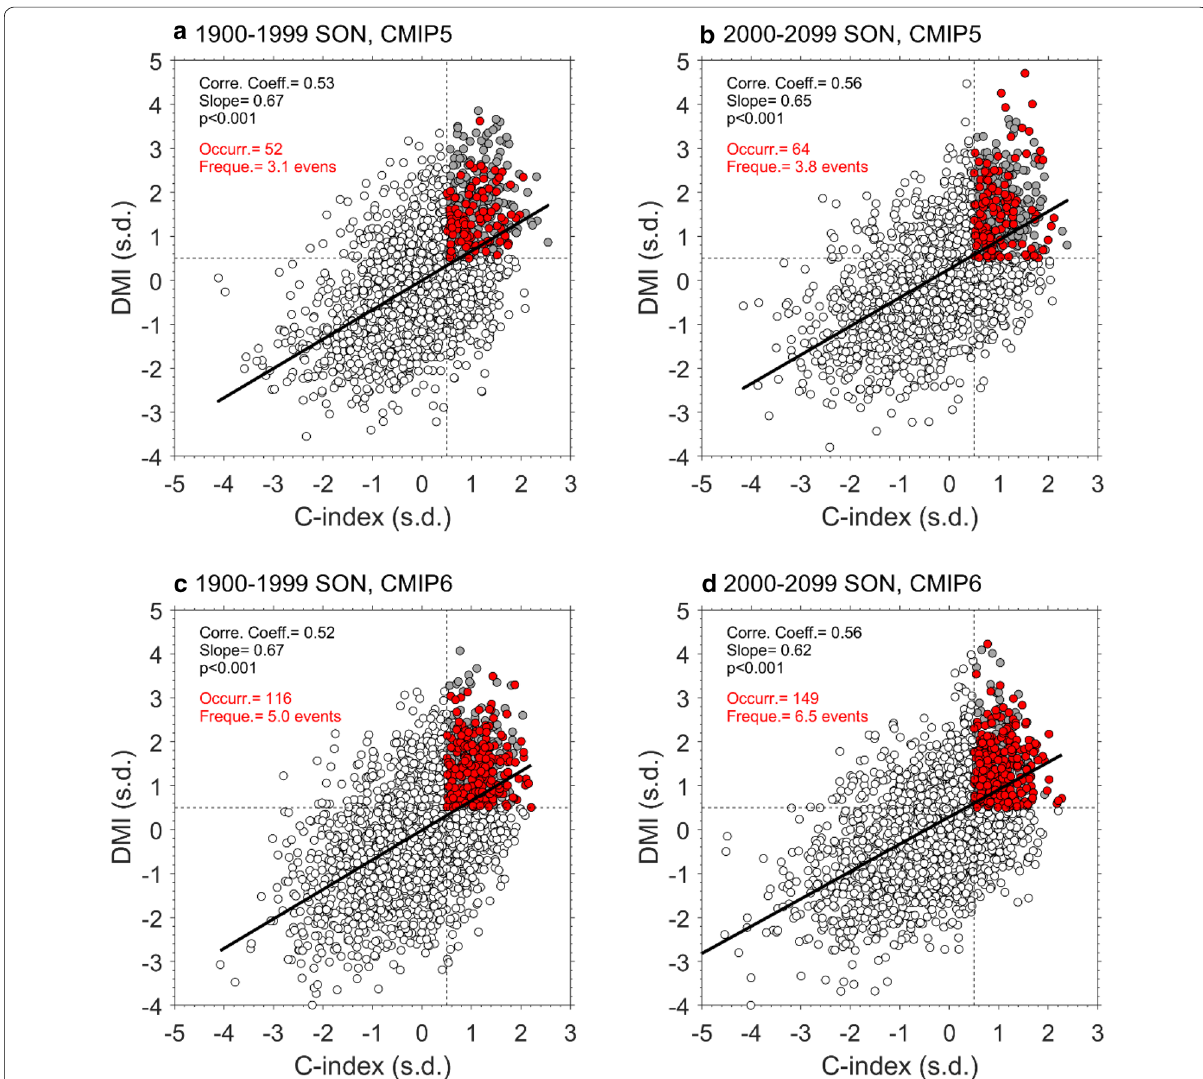
Fig. 3 Relationship between SON C-index and SON DMI. Show are based on outputs from 17 CMIP5 models for a the 1900–1999 and b the 2000–2099 periods and 23 CMIP6 models for c the 1900–1999 and d the 2000–2099 periods. See Table 1 for models that are selected for the analysis. Correlation, slope and p value are indicated in each panel. Red dots indicate events that are similar to 2018–2019 when consecutive concurrent pIOD (DMI is greater than 0.5 s.d.) and CP El Niño (C-index is greater than 0.5 s.d.) events occur for two years; dark grey dots indicate other concurrent pIOD and CP El Niño years. The total number of consecutive concurrences is indicated in red text. The associated frequency is also shown in each